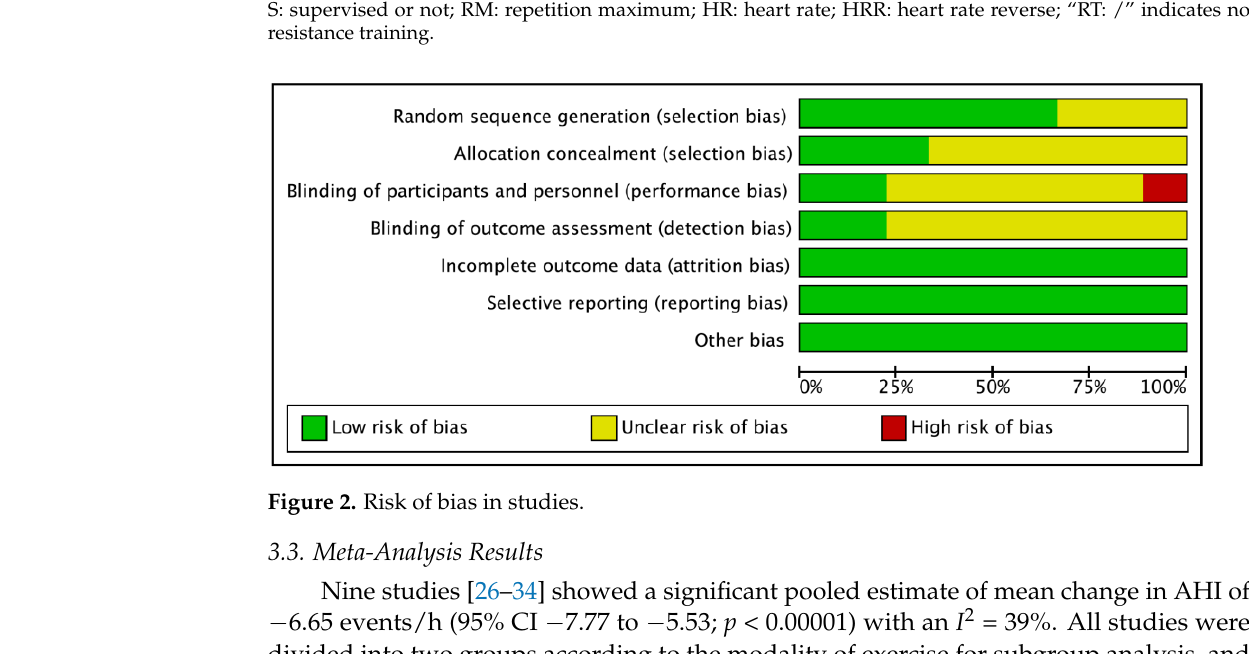
Figure 3. Meta-analysis of the pooled effect of exercise training on AHI and sub-analysis of the pooled effect of aerobic training and combined exercise training on AHI [26 – 34]. Six studies reported BMI [27 – 30,32,34]. There was no significant difference between exercise group and control group after intervention [MD = −0.57, 95%C I (−1.44 , 0.30), p = 0.20] with an I 2 = 47% (Figure 4A).